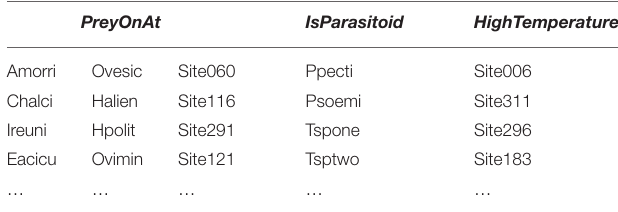
TABLE 3 | A sample of three tables for the Salix dataset (Kopelke et al., 2017). PreyOnAt